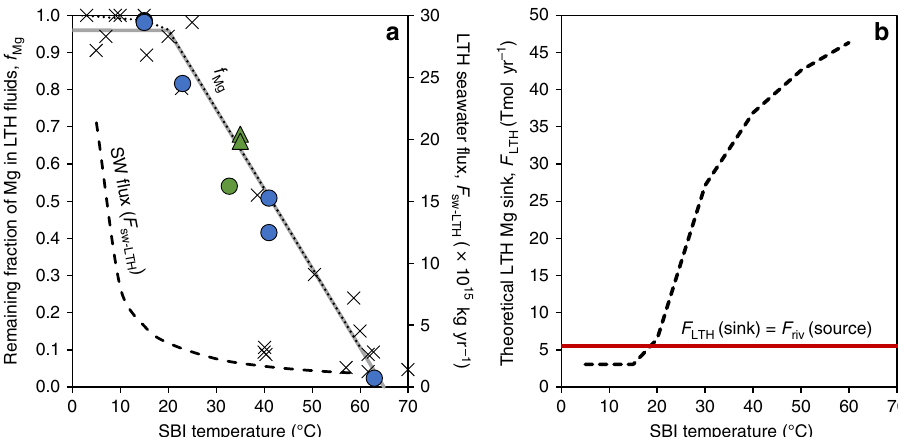
Fig. 4 Mg removal by the low-temperature hydrothermal (LTH) system. A theoretical Mg-removal fl ux is calculated from Eq. (2) assuming different theoretical globally averaged sediment – basement interface (SBI) temperatures. a The fl ux of circulating seawater through the LTH system, ( F sw-LTH ; black dashed line) and the remaining fraction of Mg in the LTH fl uids ( f Mg ; black-dotted line) were used to calculate the Mg fl ux, F LTH , in panel b. F sw-LTH was calculated using a global heat loss of 8.1 TW, a heat capacity of 4J (g ∙ °C) − 1 and a bottom seawater temperature of 2 °C. Colored data points are measured f fl uids (blue), extrapolated-SBI fl uids (green), and temperature-corrected Mg data used in current study (Table 1 and Supplementary Table 1): basement (triangles). The pore-water sample from Site 1363G (see Supplementary Table 1) was collected right at the SBI and it is thus shown in green. Other literature data 30,47 are shown by X signs. Errors are within the symbols. Gray-solid line is a correlation of f Mg literature data after Fisher and Wheat 29 , and Higgins and Schrag 40 . b A theoretical global Mg-removal fl ux by LTH systems ( F LTH ; black dashed line) as a function of average SBI temperature. The red horizontal line is the upper limit, at which the low-temperature hydrothermal Mg output matches the riverine input ( F LTH = F riv = 5.5 Tmol yr − 1 ). Any F LTH higher than the red line requires a rapid depletion of oceanic Mg, a scenario that is incompatible with oceanic Mg concentration records e.g., 49,50 . This in turn implies that the average SBI temperature must be <20